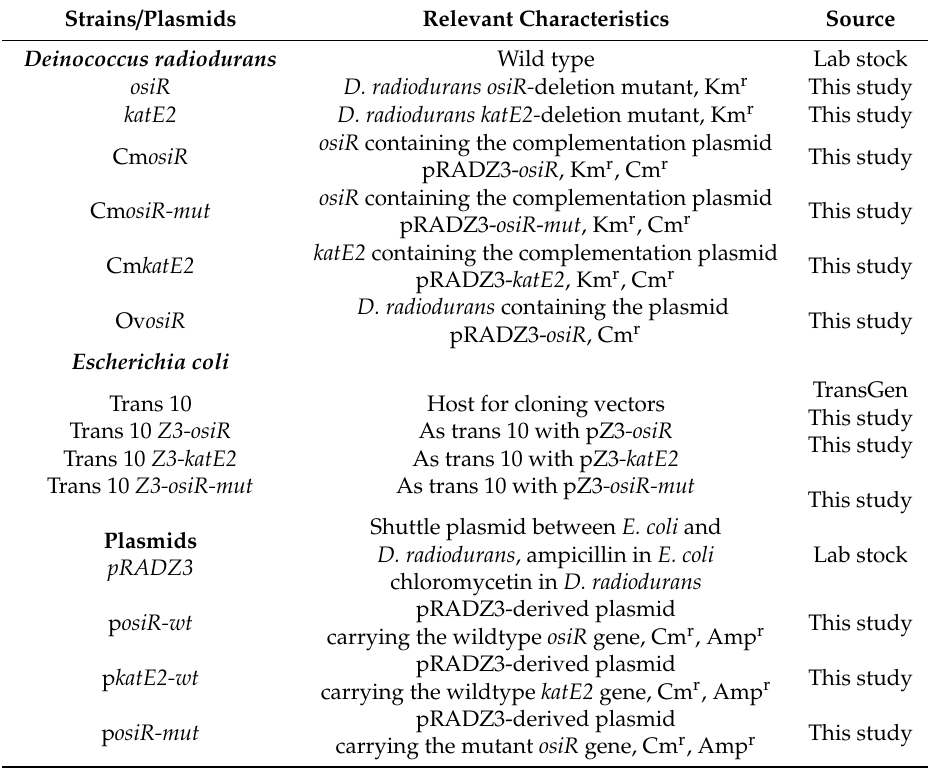
Table 1. Strains and plasmids used in this